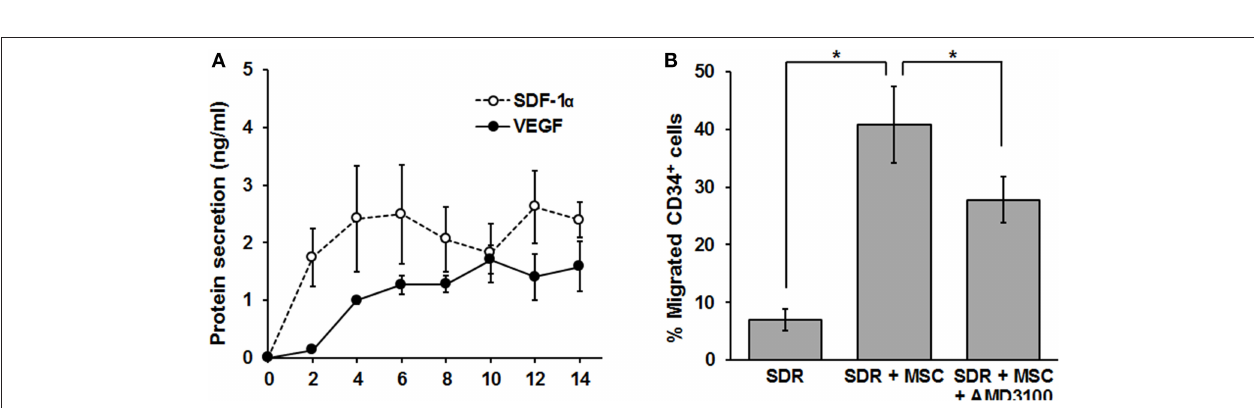
FIGURE 3 | MSC-containing SDR secrete VEGF, SDF-1 α , and induce migration of CD34 + H/EPC in vitro . (A) MSC-containing SDR were incubated with medium changes every second day. At every medium change, supernatants were collected, and VEGF and SDF-1 α protein levels measured by ELISA. Average of MSC from 3 different donors are shown. (B) Supernatant of SDR (control) and SDR + MSC were collected after 48h incubation and tested for CD34 + H/EPC migration in a transwell assay, as described in the Materials and Methods Section. In addition, AMD3100 (100ng/ml) was added to the SDR + MSC condition during the transwell assay. Average of CD34 + of 3 different donors using MSCs from 2 different donors are shown. * p < 0.05